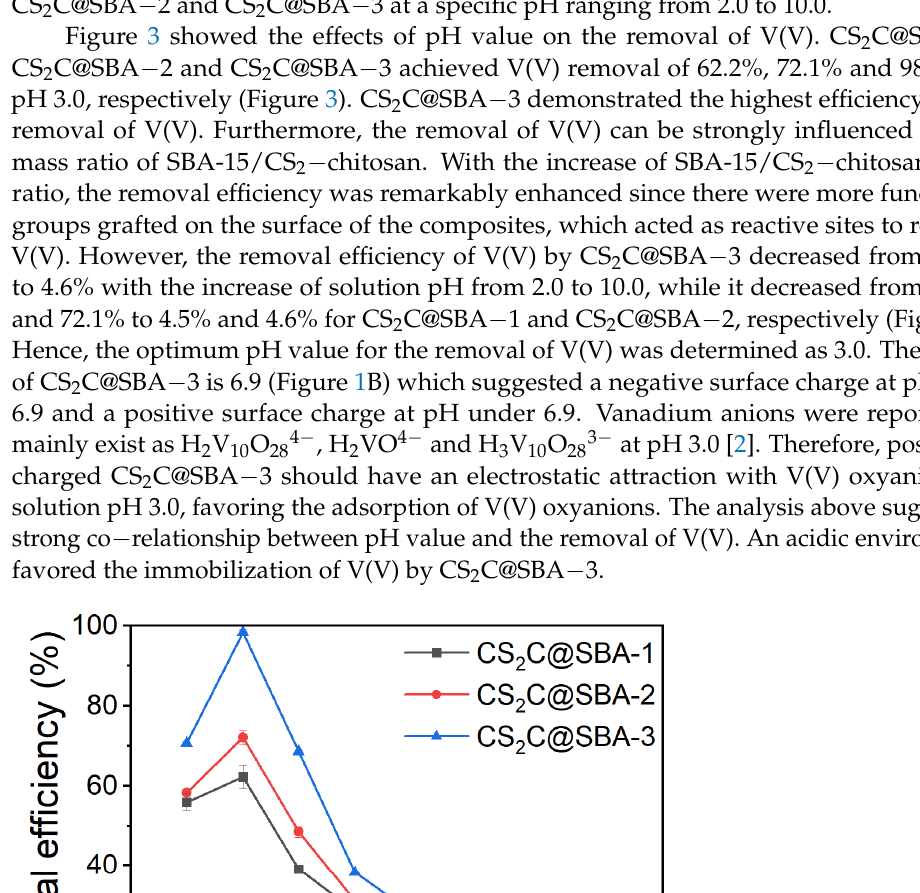
5 of 18 Figure 2. SEM images of SBA − 15 ( A ) and ( B ); CS 2 − chitosan ( C ) and ( D ); CS 2 C@SBA − 3 ( E ) and ( F ).